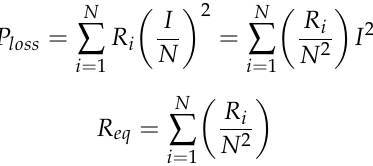
Figure 3. House floor plan and wiring diagram.